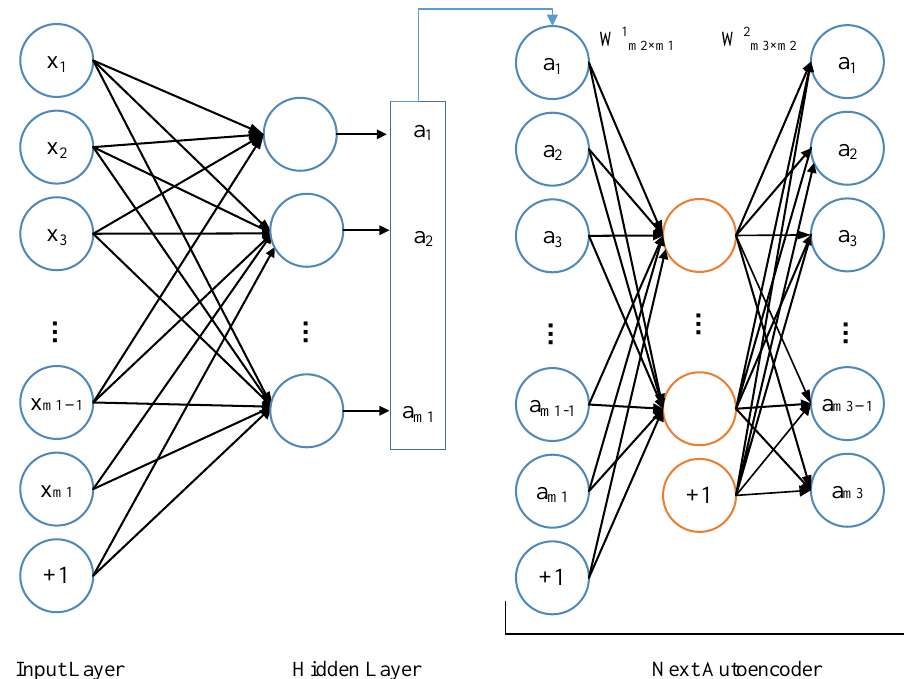
Figure 2. The activations of previous AEs are used to train the latter